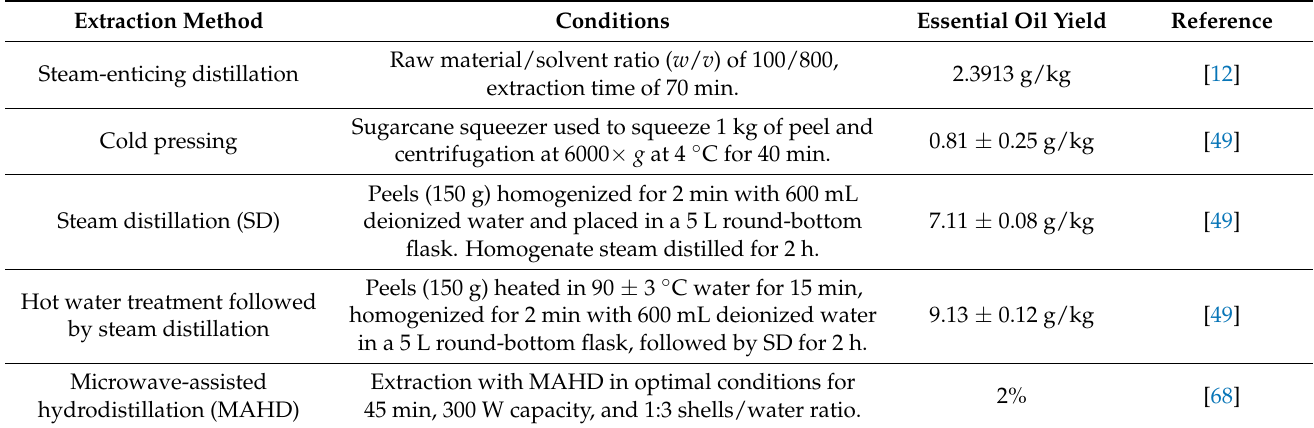
Table 5. Comparison of essential oils extracted from calamondin fruits by various methods. Extraction Method Conditions Raw material/solvent ratio ( w / v ) of 100/800, Steam-enticing distillation extraction time of 70